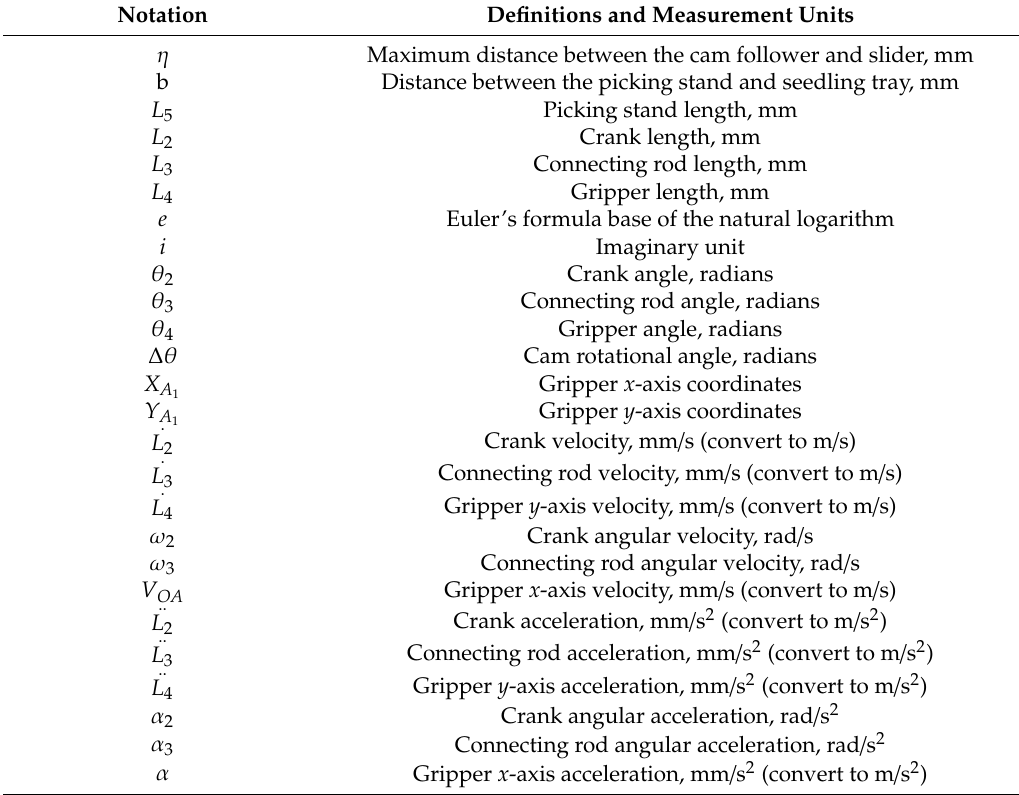
Table 1. Variable notations, definitions, and measurement